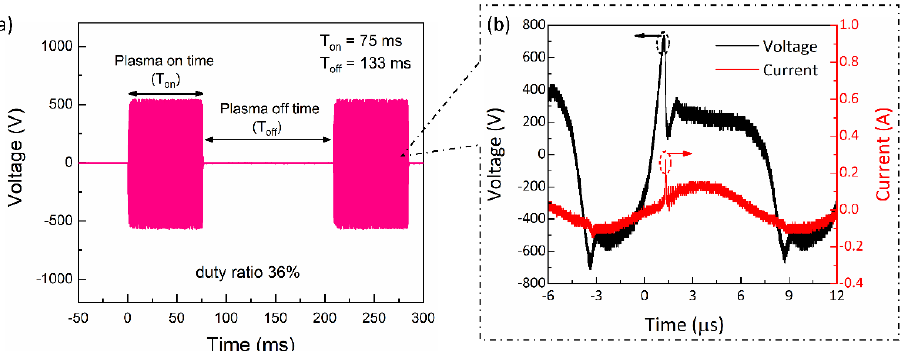
Figure 2. Electrical properties of discharge. ( a ) The discharge waveform shows plasma on–time (T on ) of 75 ms and off ‐ time (T off ) of 133 ms with a 36% duty ratio. ( b ) A plot of the discharge current versus time in terms of current (red) and voltage (black). The current–voltage waveform was recorded when the duty ratio was 36%.